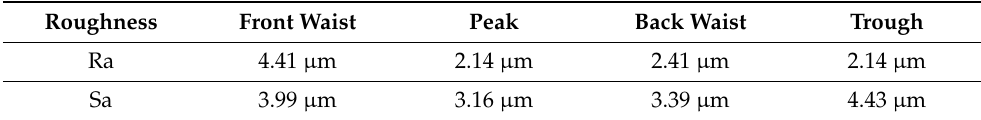
Table 3. Roughness statistics of Al matrix fracture